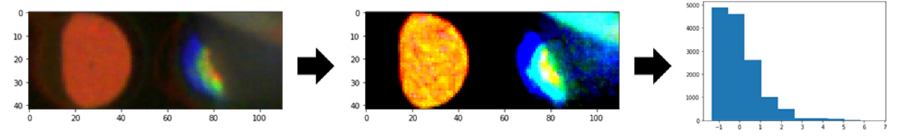
Figure 7. Normalization.